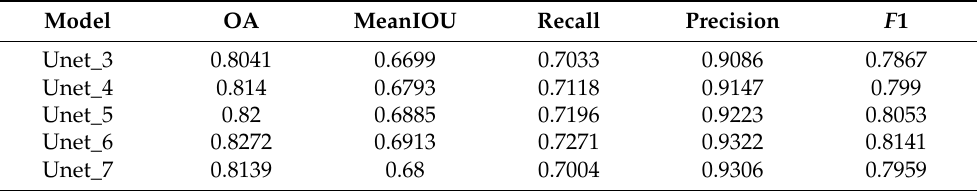
Table 3. Results of the accuracy evaluation for models with different depths.